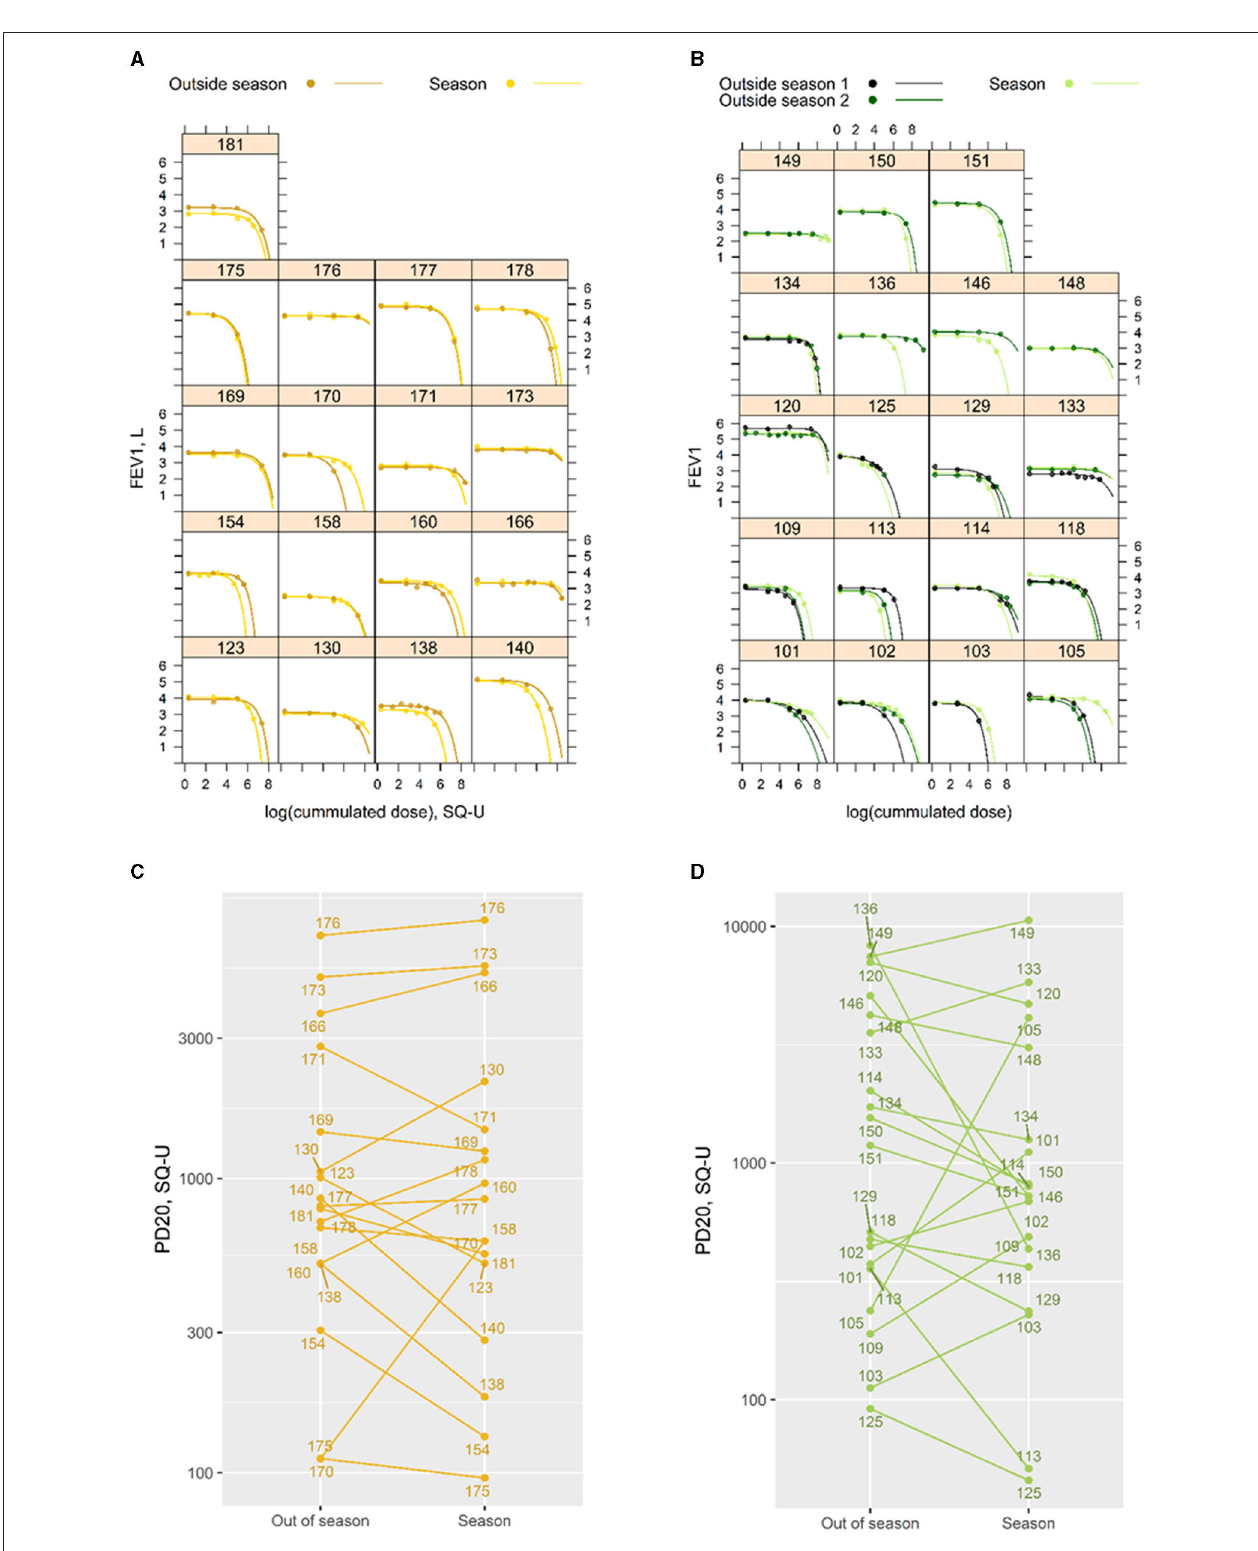
FIGURE 3 | ( A left + B right) Individual modeled dose-response profiles for the 17 participants challenged with birch allergen (left) and the 19 challenged with grass allergen (right). The numbers indicate the individual IDs of participants. Thirteen of the grass participants were challenged two times outside the season. ( C left + D right) Individual PD 20 estimates for challenges “out of season” and at the end of “season.” Estimates are shown for the 17 participants challenged with birch (left) and the 19 challenged with grass allergen (right). The numbers indicate the individual IDs of participants.